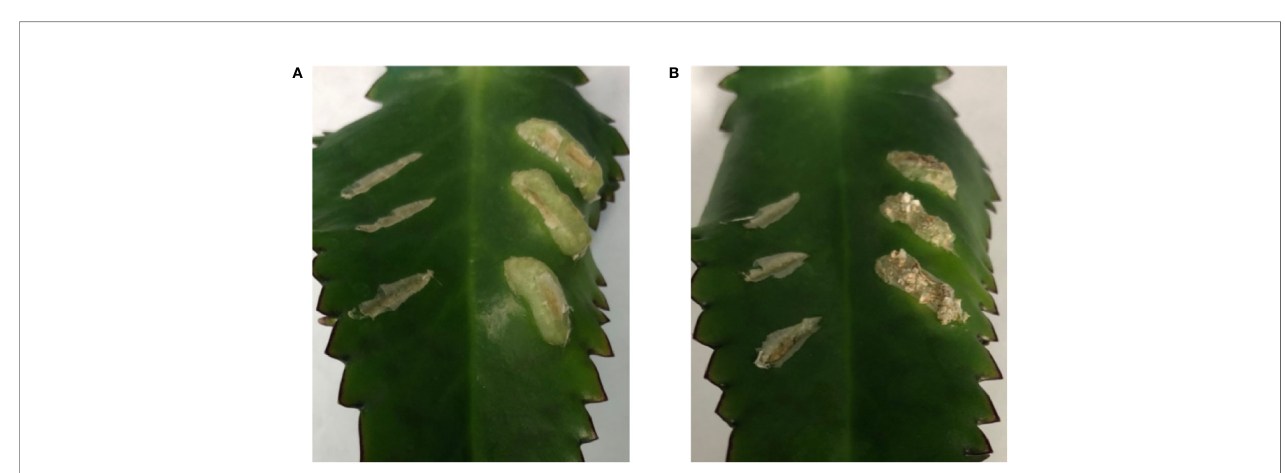
FIGURE 8 | Both VirA wt and VirA Y293F Agrobacterium induce crown gall tumors. Kalanchoe diagremontiana leaves were inoculated with A348 wt (A) and YHL320 s+ (B) in triplicate on the right of each leaf, while the wounds to the left were left as controls. Tumors for A348 wt appeared larger and more uniform.